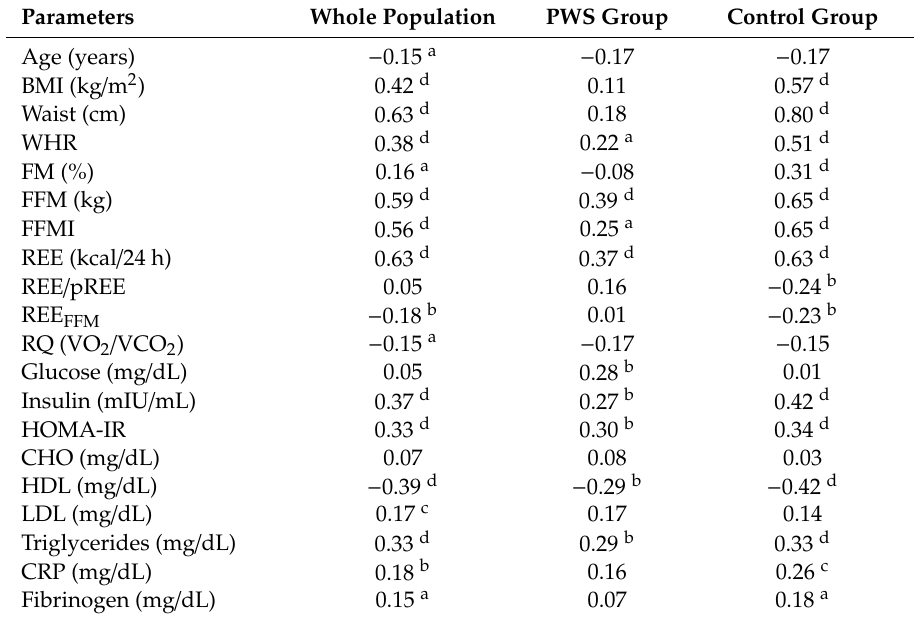
Table 2. Pearson’s correlation analysis between sUA levels (mg / dL) and variables of interest in merged and separated study groups. The correlation coe ffi cient r and significance are